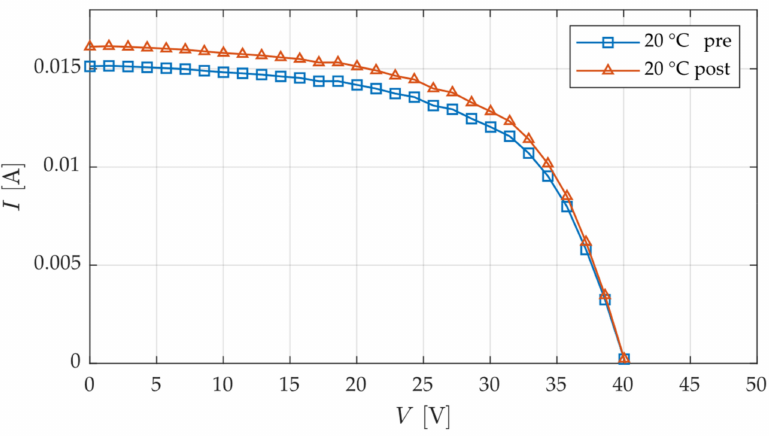
Figure 12. I-V characteristic of sample Al 3 in the fourth quadrant at 20 ◦ C before and after the exposure to vacuum (1 × 10 − 5 mbar) at 100 ◦ C for 72 h.